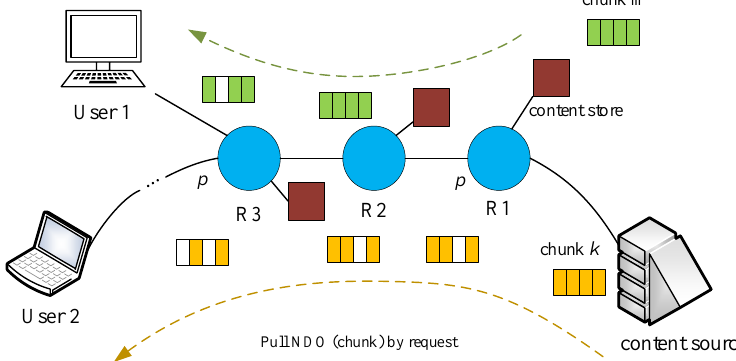
Figure 3. A linear topology using to indicate that forwarding traffic should have higher priority when bandwidth competition happen.